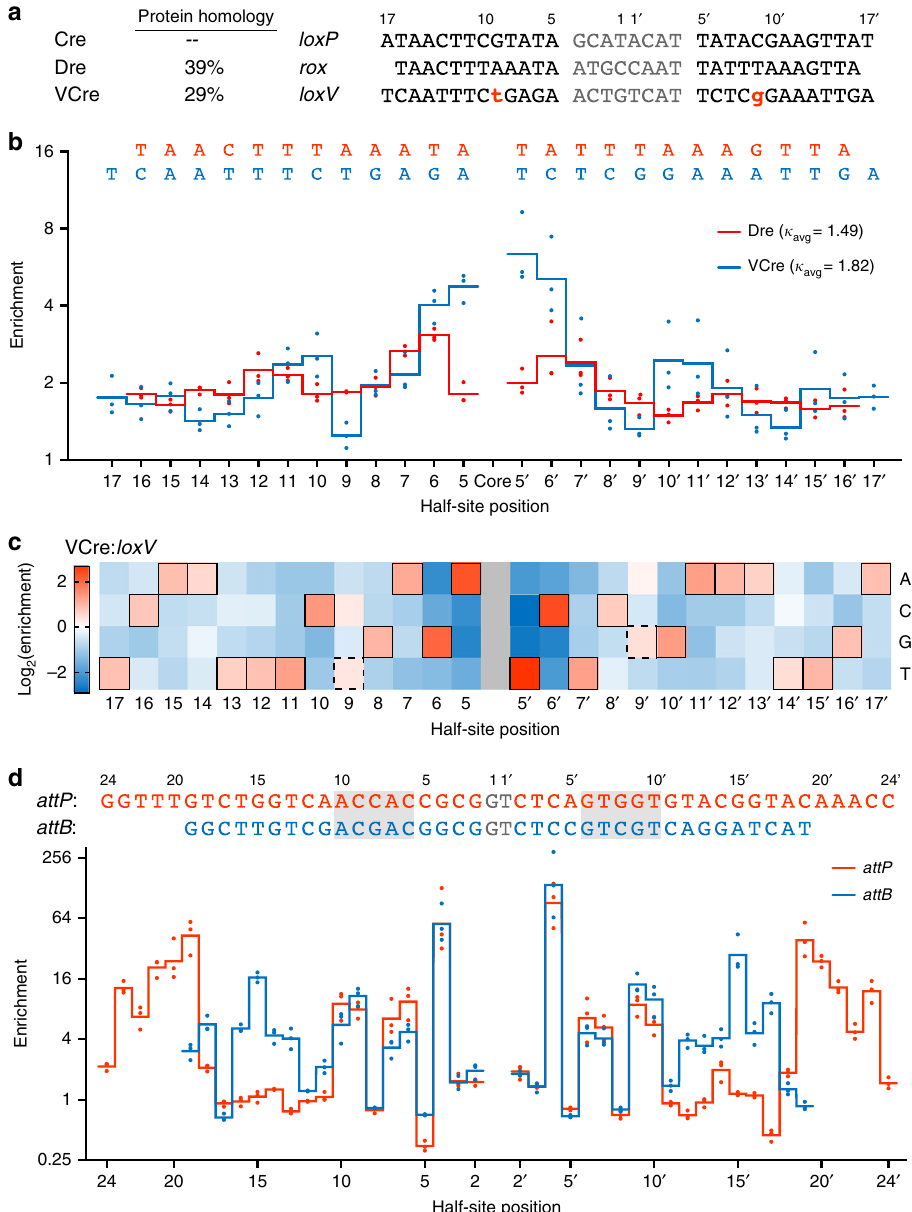
Fig. 4 Rec-seq pro fi les of Dre, VCre, and Bxb1 site-speci fi c recombinases. a Cre, Dre, and VCre differ at the protein sequence level, and bind different recognition targets. b Rec-seq of tyrosine recombinases Dre and VCre. Values represent the geometric mean of n = 3 independent replicates (dots) conducted at 37 °C for 30 min at a 3:1 protein:DNA ratio. c Heat map of Rec-seq enrichment values for VCre showing the log 2 of the enrichment value for each nucleotide at each position in loxV relative to the canonical base (black outline). d Rec-seq of serine integrase Bxb1 on its substrates attP and attB . Both substrates contain a conserved ACNAC motif (gray box). Values represent the geometric mean of n = 3 independent replicates (dots) conducted at 37 °C for 30 min at a 3:1 protein:DNA ratio. Source data are provided as a Source Data fi